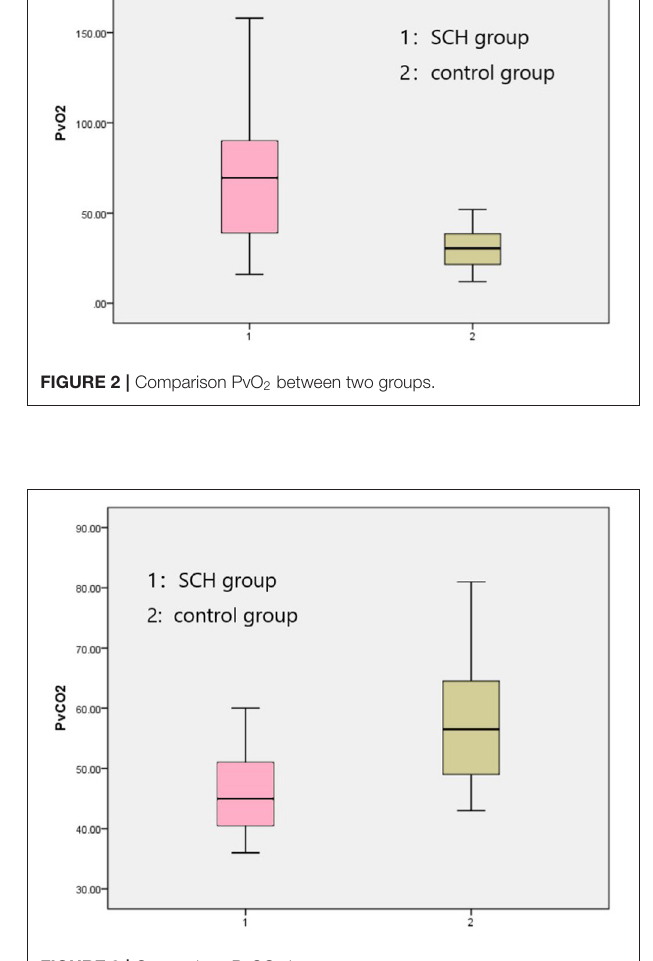
FIGURE 3 | Comparison PvCO 2 between two